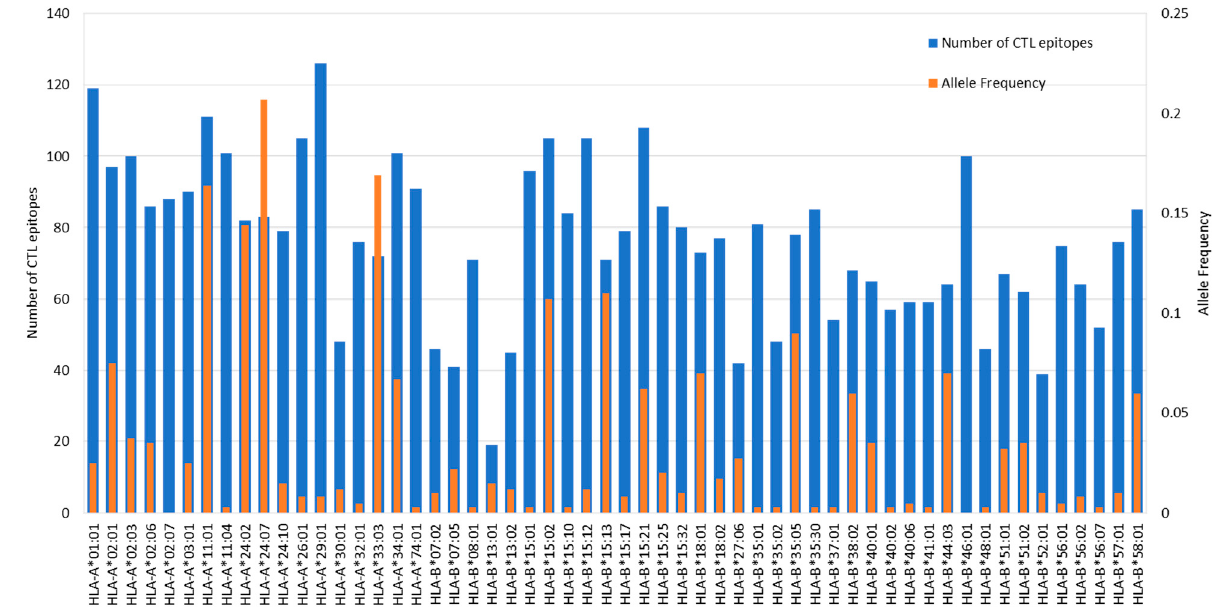
Figure 4. The number of predicted CTL epitopes that are presented by the HLA Class I allele. NetCTLpan 1.1 predicted 1132 9-mer peptides that bind to at least 1 HLA Class I alleles with the percentile rank of less than 1%.